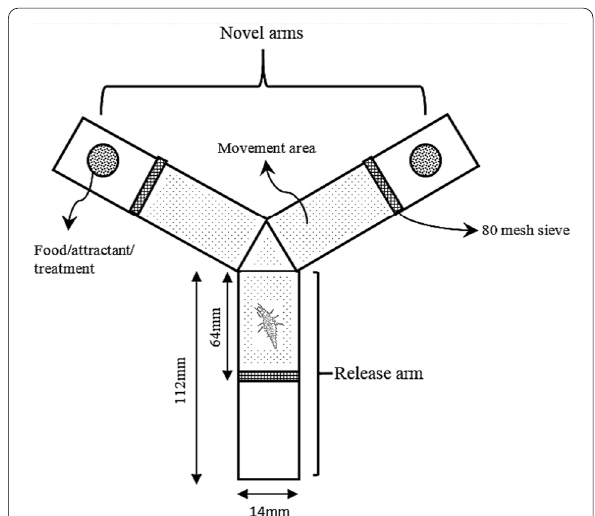
Fig. 1 Layout of arena used for video